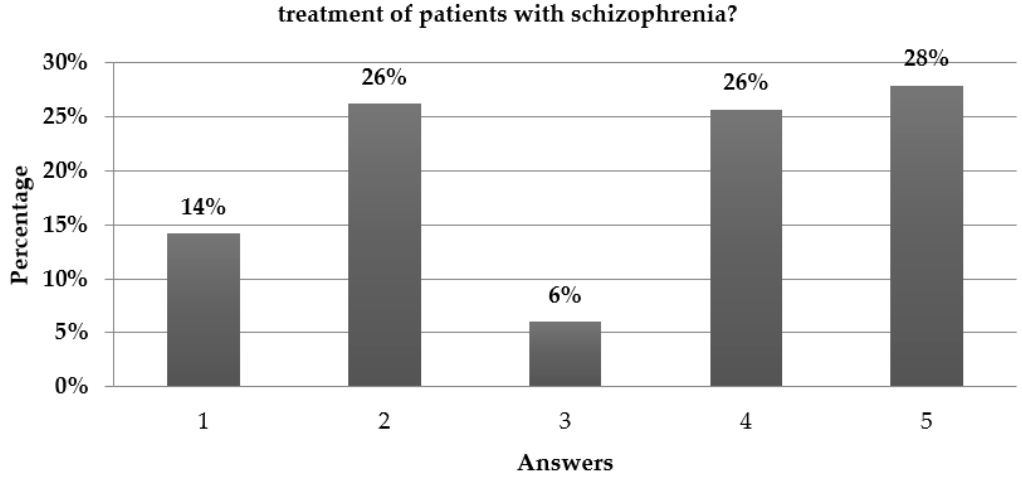
Figure 1. Factors influencing the medical decision-making regarding treatment of schizophrenia.